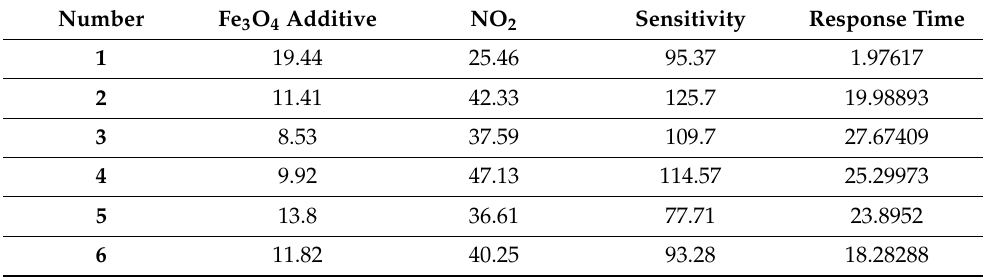
Table 3. Suggested optimized values for desirable lower response time of the gas sensor system.